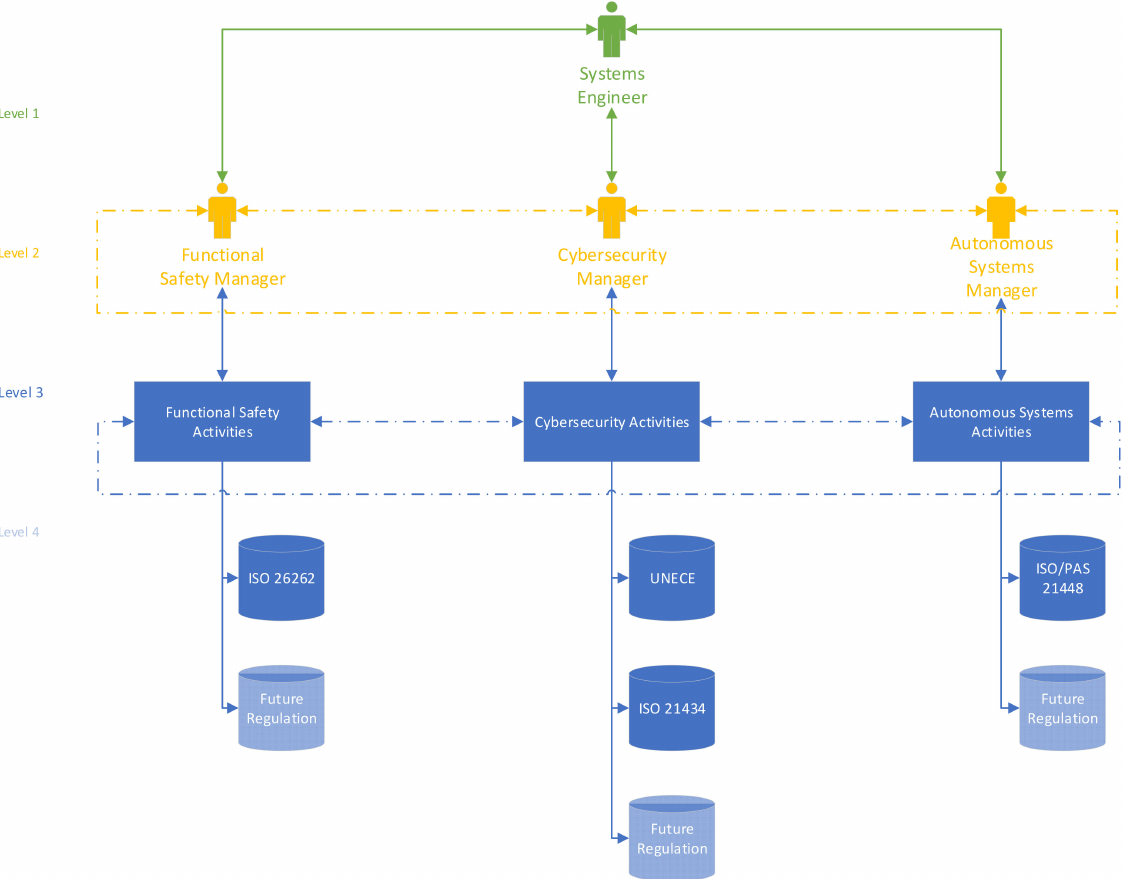
Figure 10. Coordination of ECU